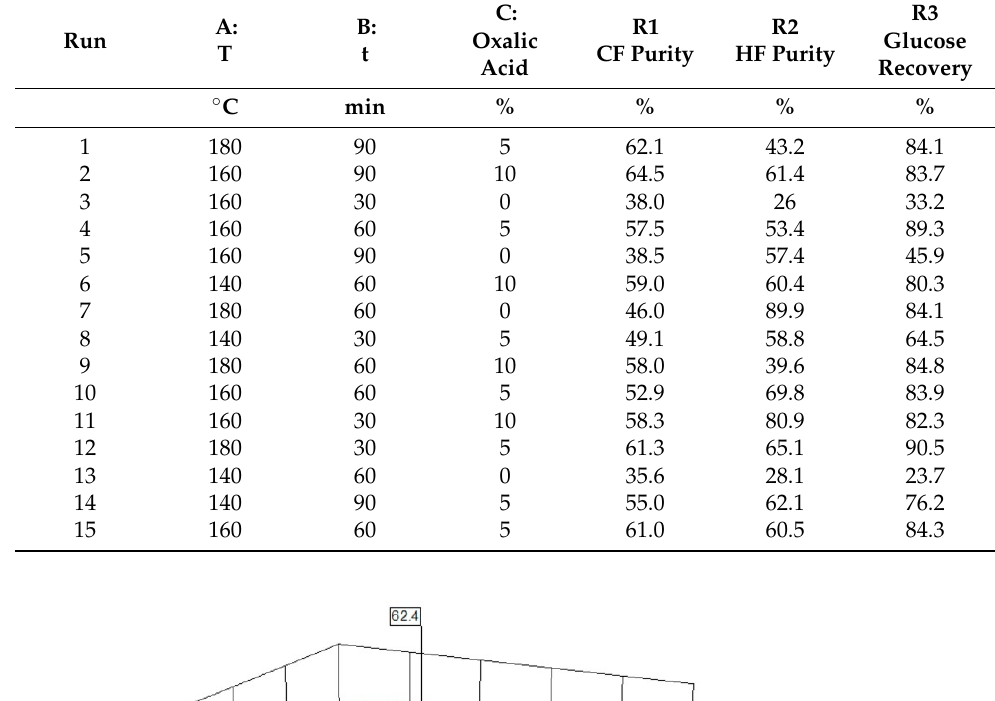
Table 2. Experimental design plan and experimental data obtained for WS pretreatment with and butanol.